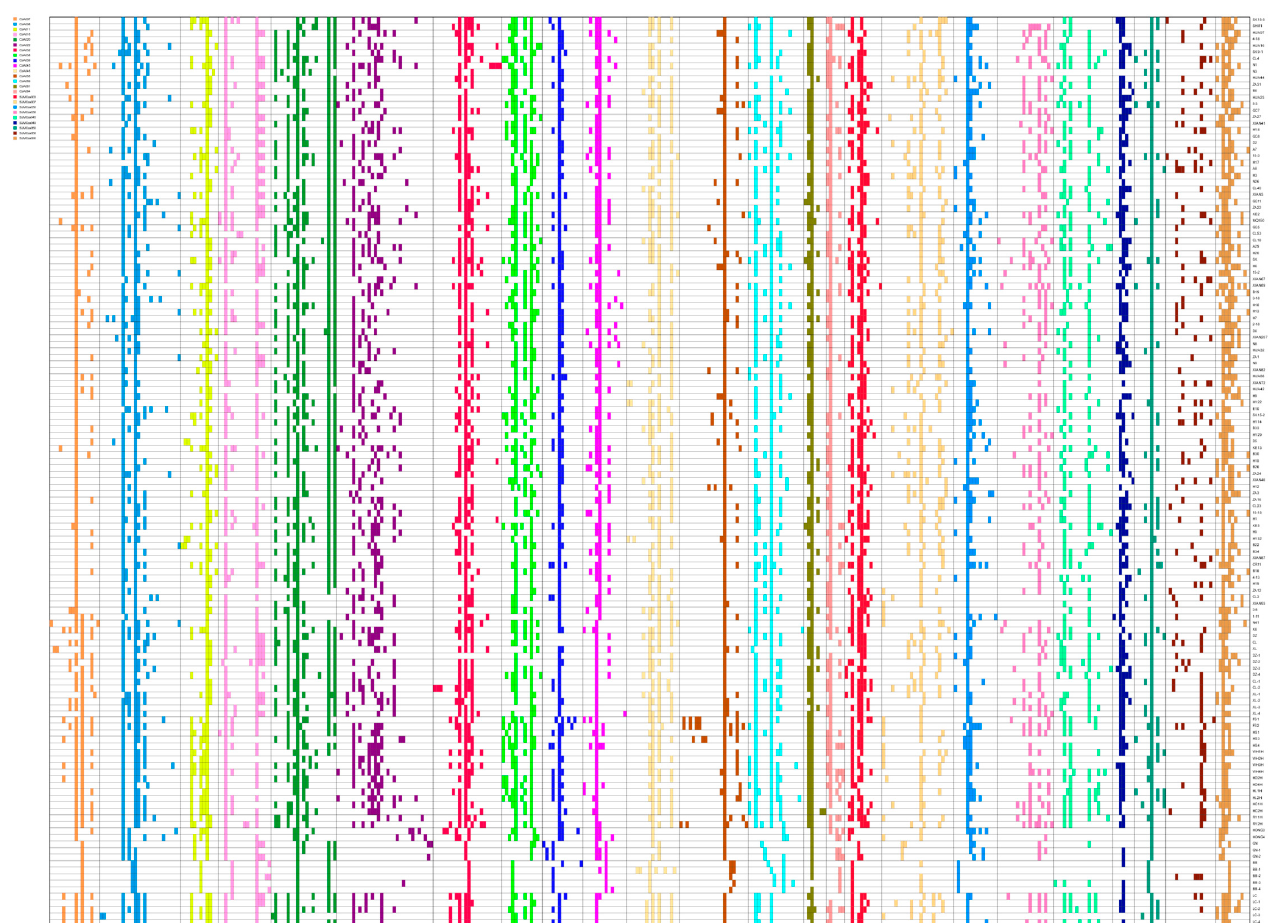
Figure 1. The fingerprinting of each allele in 140 samples.